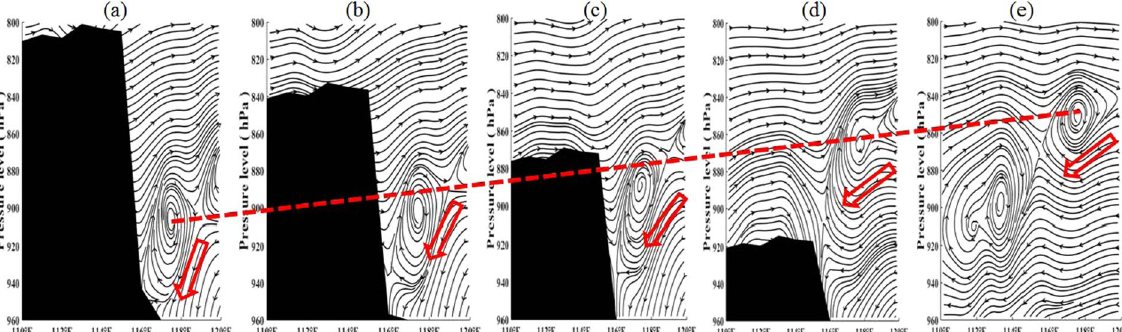
Figure 7. Profiles of simulated zonal and vertical winds along 39.5–40.5°N in the S5 ( a ), S1 ( b ), S2 ( c ), S3 ( d ), and S4 ( e ) scenario from November 7 th to 16 th . The vertical winds have been multiplied by 400; the opaque regions denote the terrain.